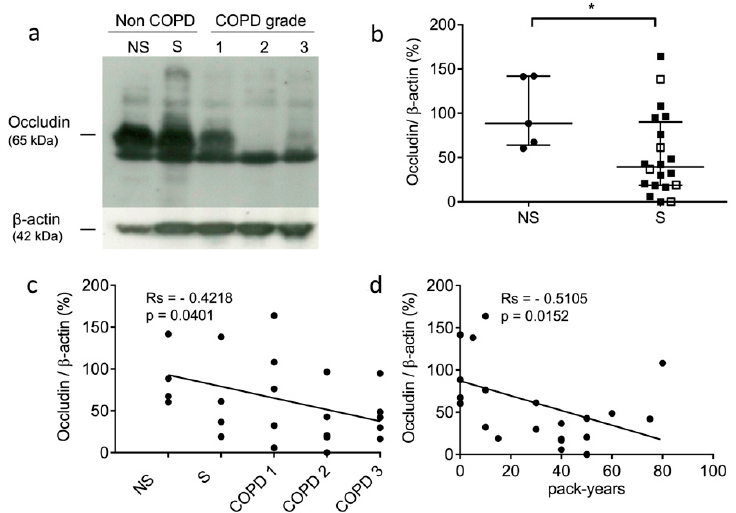
Figure 1. Expression level of occludin in lung tissue samples. ( a ): Western blot analysis (lung tissue lysates, 100 µg of total proteins/sample). Representative samples correspond to non-COPD never- smokers (NS), non-COPD smokers (S), and COPD patients (all being smokers with different stages of COPD severity): GOLD (Global initiative for chronic Obstructive Lung Disease) 1 (mild stage), GOLD 2 (moderate stage), and GOLD 3 (severe stage). ( b ): Densitometric analysis of occludin expression level (normalized data using β -actin as control; ImageJ software). Bars represent median ± quartile. Statistical significance was assessed using Mann–Whitney test (* p < 0.05). ( c ): Correlation between occludin level and patient status (NS, S, and COPD grades; GOLD 1–GOLD 3). ( d ): Correlation between occludin level and pack years (i.e., smoking history). Correlations were determined by linear regression and indicated by Spearman coefficient (Rs) and levels of significance ( p ).